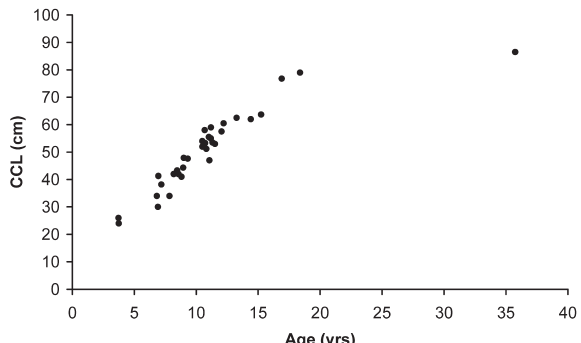
Fig . 5. – Age of 33 loggerhead turtles estimated with the age at size (AS) method.